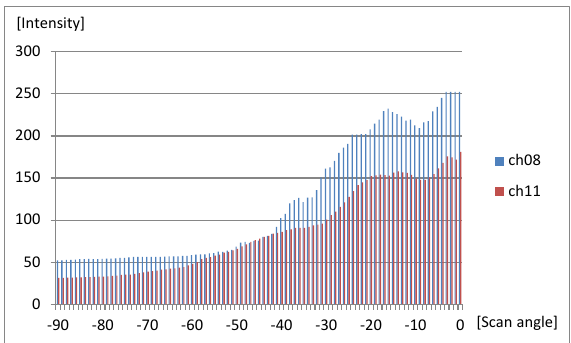
Figure 14. Reflection intensity and scan